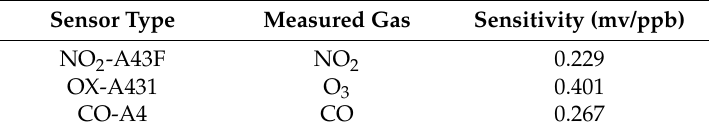
Table 1. List sensor selection for different